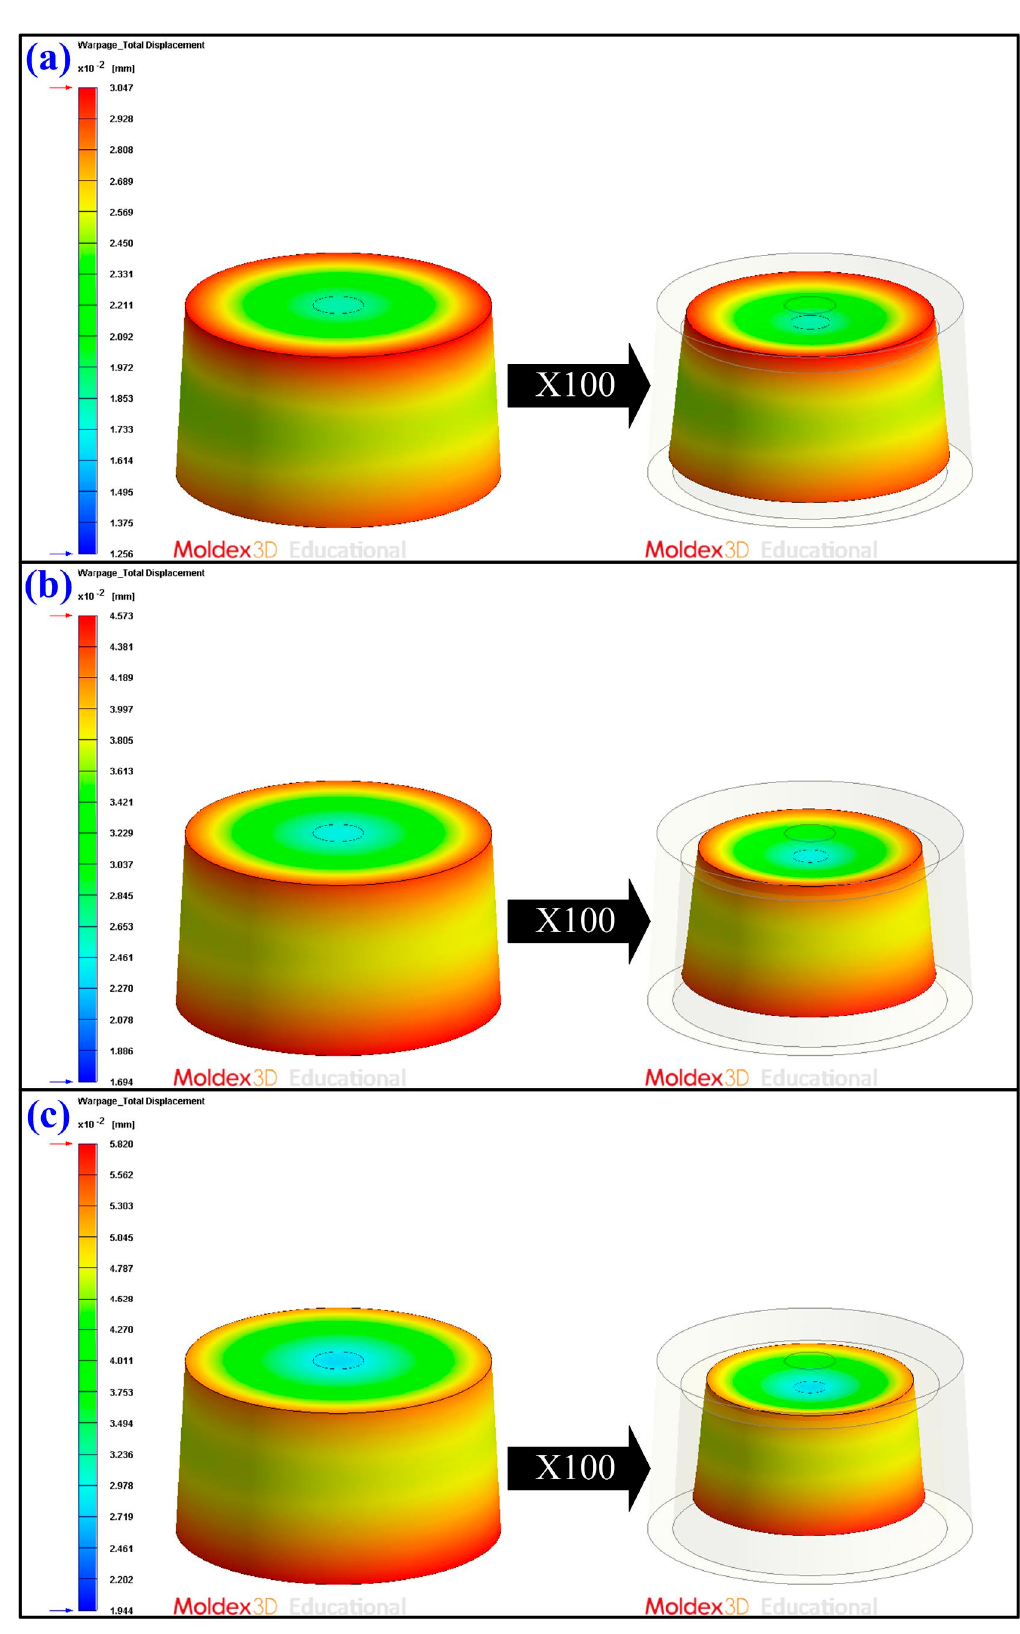
Figure 14. Numerical simulation results of the warpage of the molded parts for ( a ) conventional SRM, ( b ) SRM with 60 wt.% Al powder, ( c ) SRM made with recipe 4.